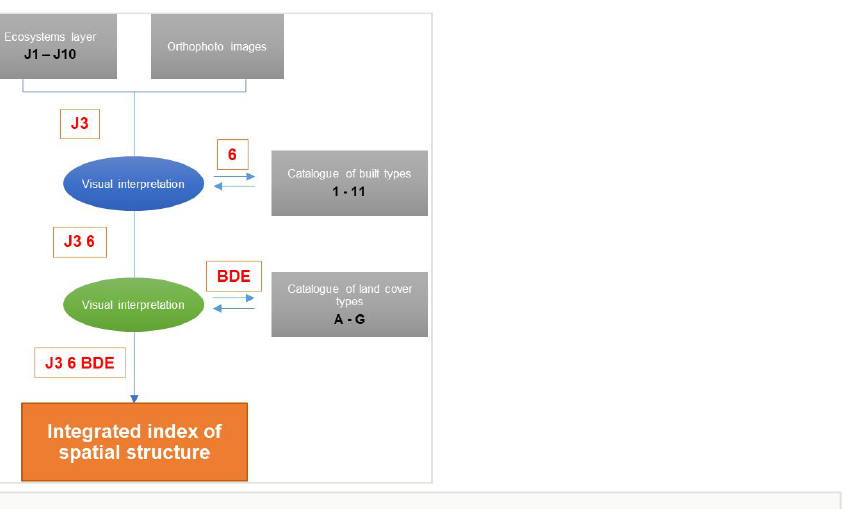
Conceptual scheme for index generation. The digits in red are examples corresponding to Fig.